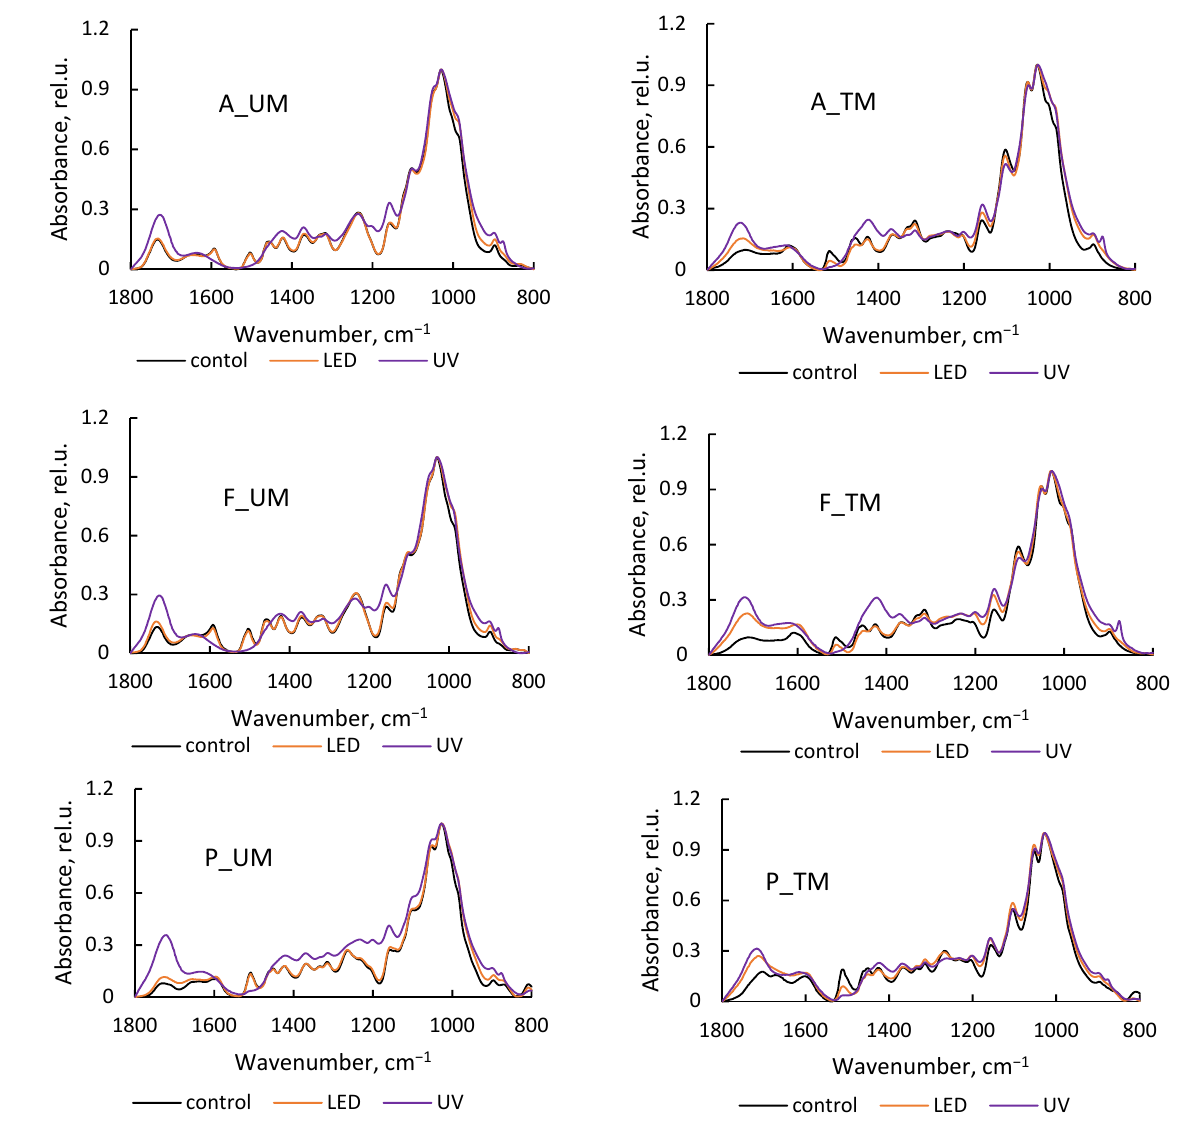
Figure 4. FTIR-ATR spectra of unmodified (UM) and thermally modified (TM) of aspen (A), ash (F), and pine (P) before (control) and after exposure to UV radiation and LED lamps.